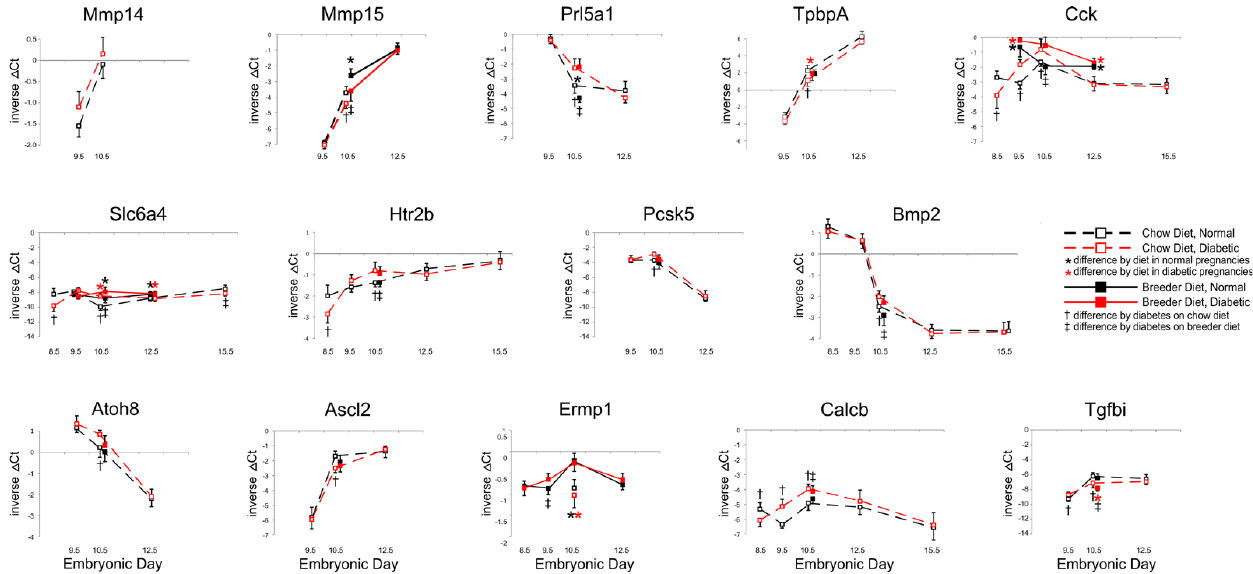
Figure 3. Expression of genes with roles in embryonic and placental development. Quantitative PCR measurements were performed at various time points, in dams that were either fed chow or breeder diet, and became diabetic in the week before, or were normoglycemic at the time of mating. However, from some of the temporal trajectories it is not intuitively obvious how changes in expression of these genes could explain the reduced growth of the placenta after E12.5, particularly in diabetic breeder-diet-fed dams. It cannot be excluded that the observed changes at midgestation (E10.5, or even earlier) could subsequently influence signaling pathways that were not included in our investigations. It is important to note here that technical factors are unlikely to account for the large number of genes with